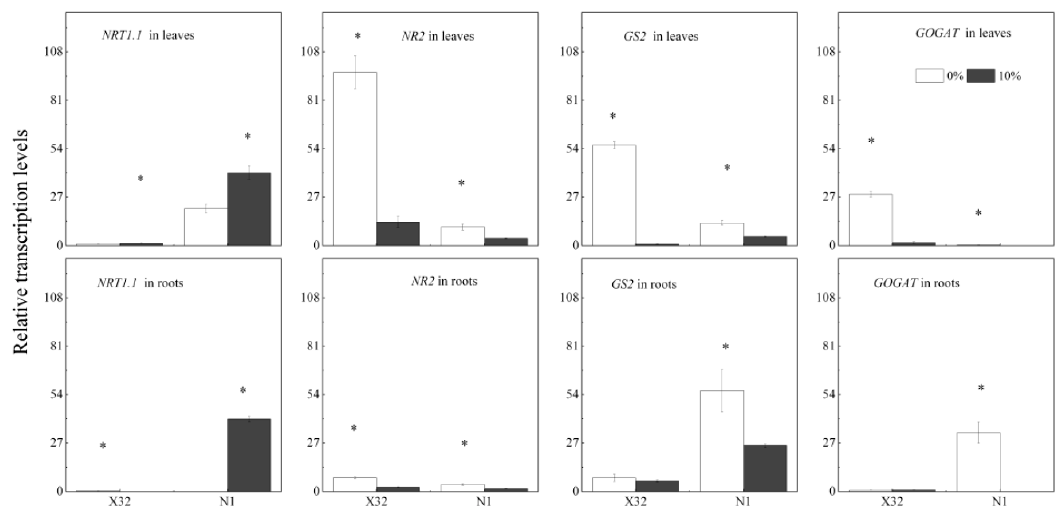
Figure 13. E ff ects of drought stress on the transcription of N metabolism-related genes in leaves and roots of two sweet potato cultivars. Sweet potato seedlings were subjected to 5 days of drought stress (10% PEG); total RNA was isolated from leaves and roots for real-time PCR analysis. X32 and N1 represent Xushu 32 and Ningzishu 1, respectively. The stages labeled with an asterisk (*) indicate significant di ff erences ( p < 0.05) between the 0% and 10% PEG levels in the